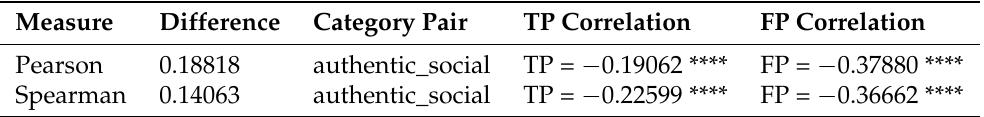
Table 13. Authentic and Social in